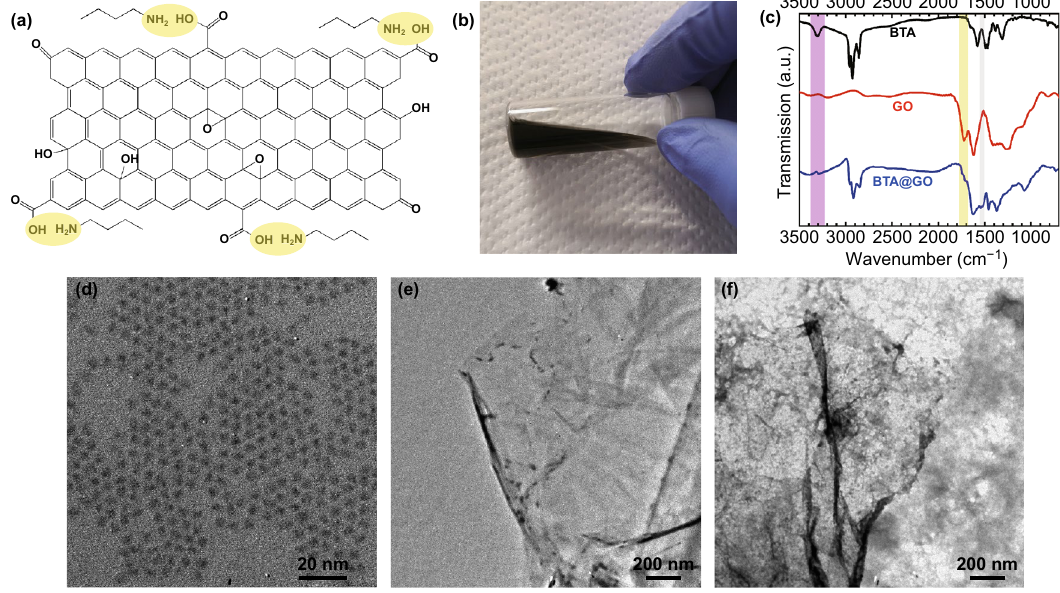
Fig. 1 a Chemical structure of the GO and the formation mechanism of BTA@GO. b Photograph of BTA@GO solution (0.3 mg mL −1 ). c FTIR spectra of BTA, GO and BTA@GO on glass/Au substrate. d TEM image of colloidal PbS-OA CQD. TEM images of e BTA@GO and f PbS-